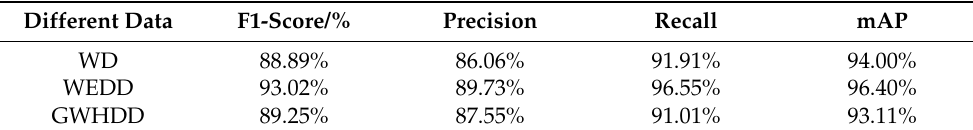
Table 2. Evaluation indicators of wheat ear detection of three data sets.